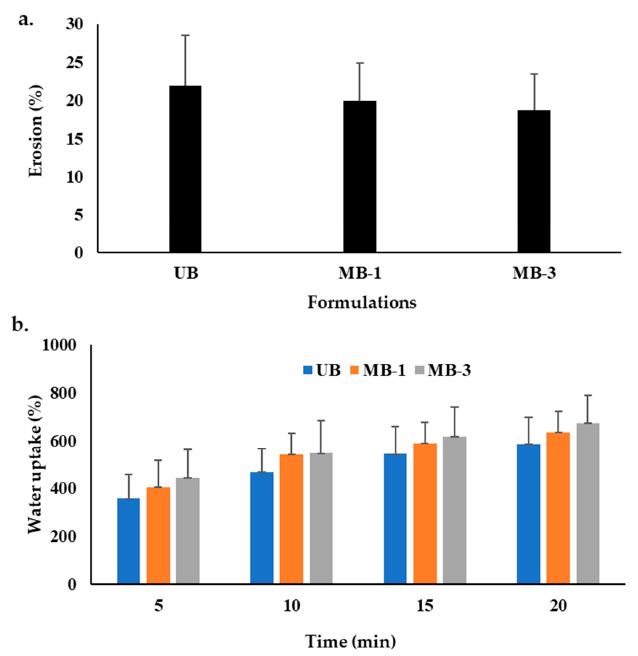
Figure 3. ( a ) Percentage erosion, and ( b ) Water uptake ability of various film